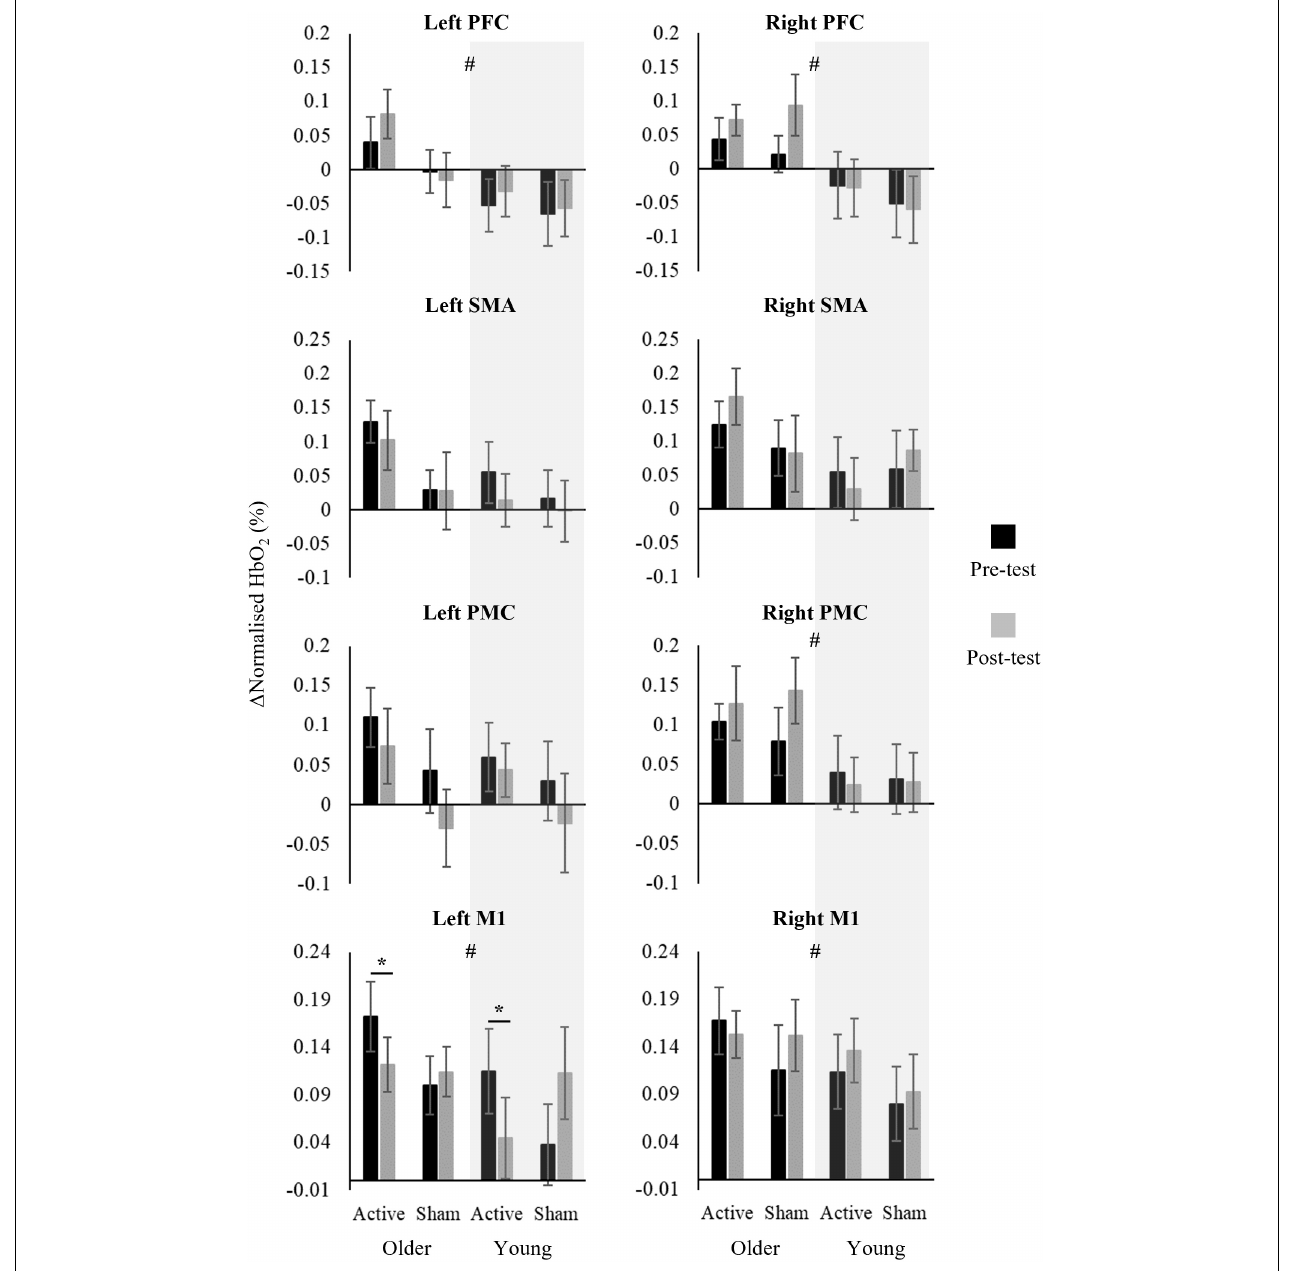
FIGURE 4 | Means and standard errors of change in oxygenated hemoglobin ( (cid:49) HbO 2 = DTW periods minus STW periods) in pre- and post-intervention walking test of active-Older adults ( n = 10), sham-Older adults ( n = 8), active-Young adults ( n = 12) and sham-Young adults ( n = 11). # indicates significant main effect of age group and * indicates significant interaction between stimulation condition and